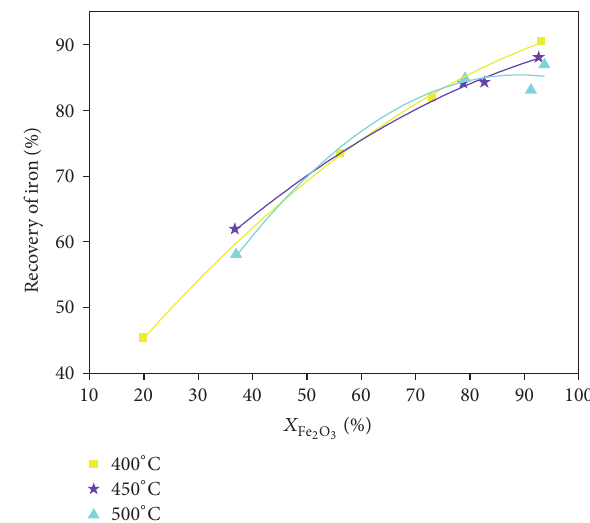
Figure 17: Dependence of iron recovery on the conversion of Fe 2 O 3